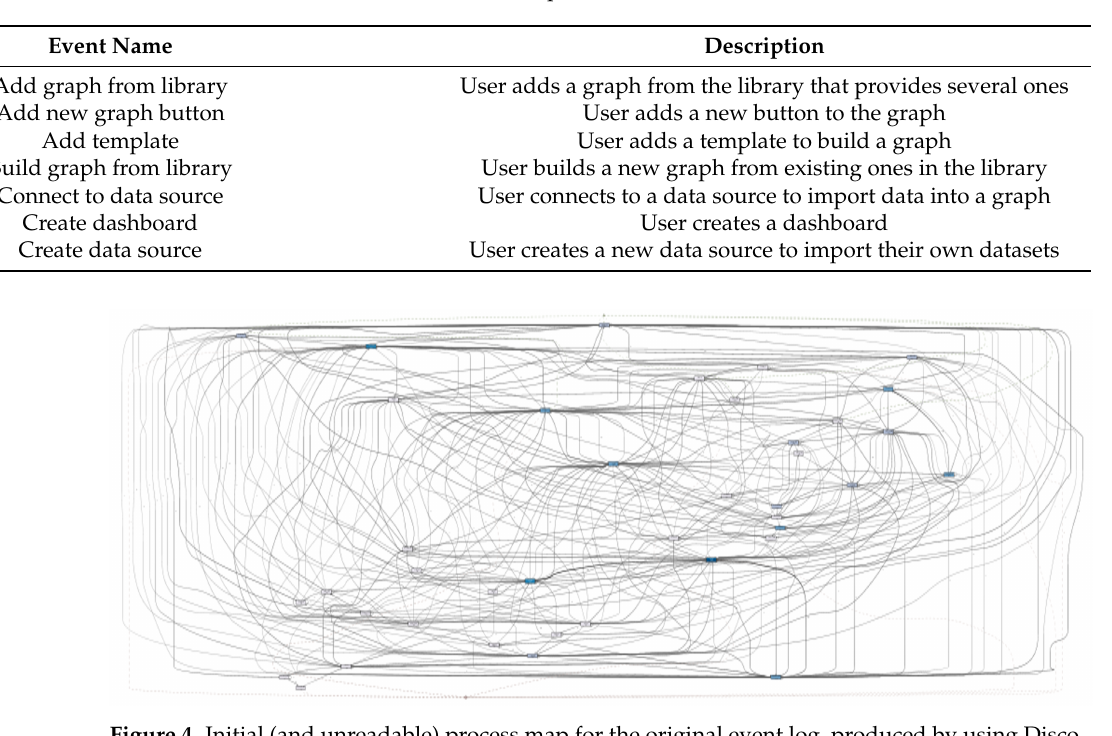
Figure 4. Initial (and unreadable) process map for the original event log, produced by using